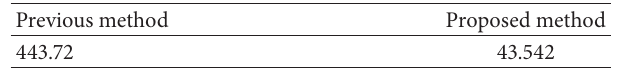
Table 5: The optimal polarization parameters got by two methods in a special circumstance (rad).